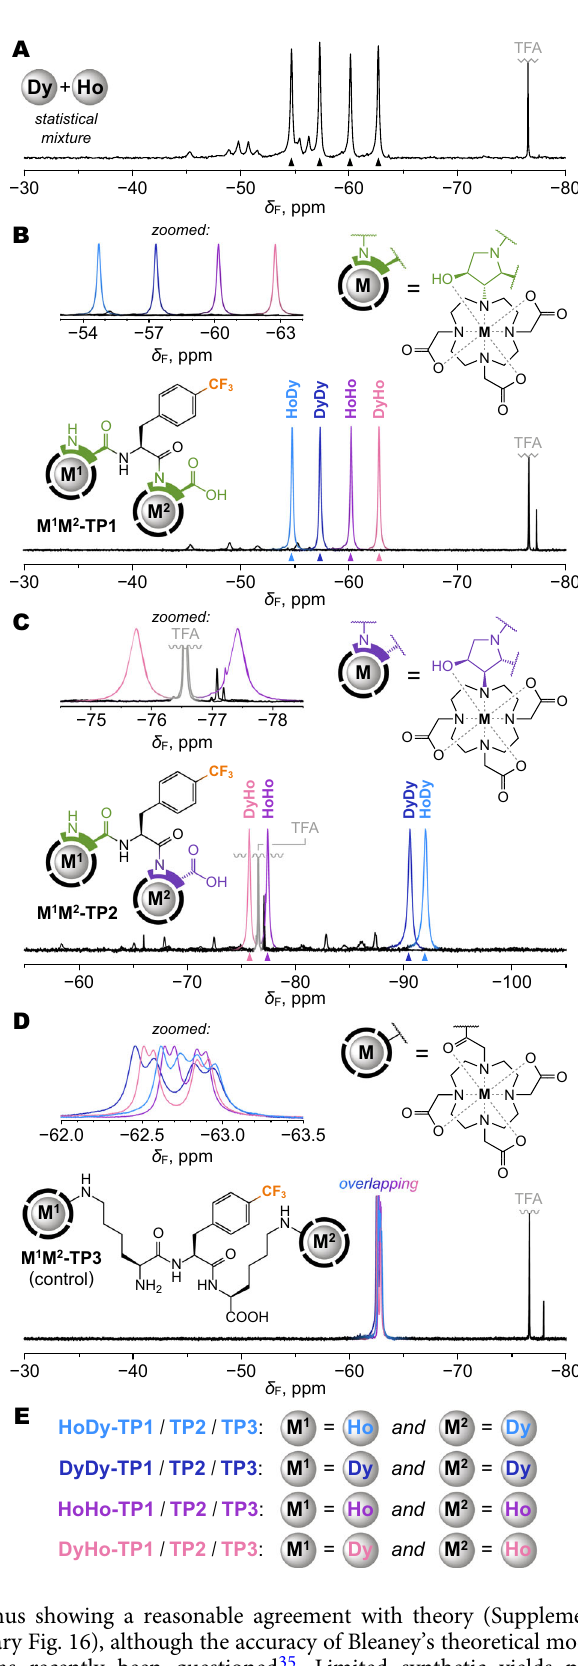
channel and decoded back to the original components. Che-